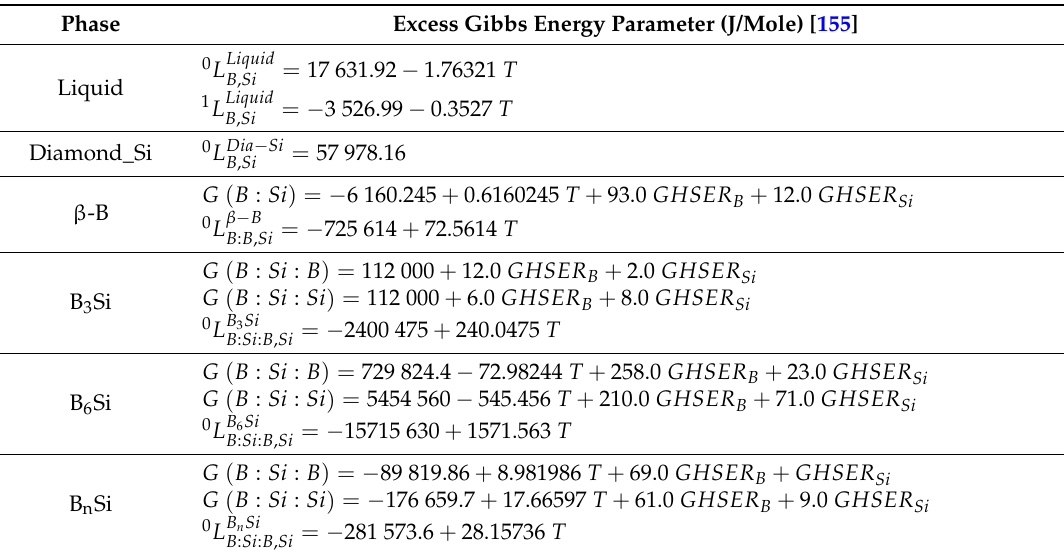
Table 7. Thermodynamic model parameters of the B-Si